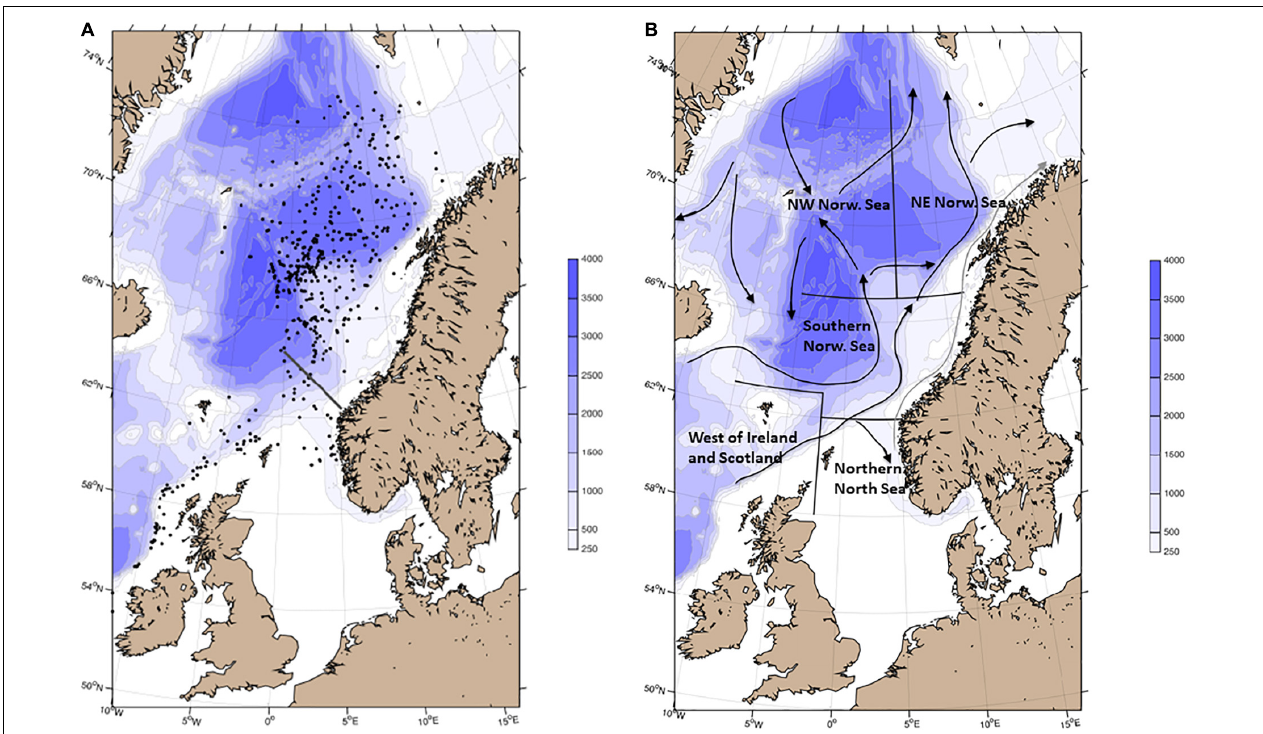
FIGURE 1 | (A) The geographic distribution of sampled post-smolts. Each circle represents a location where post-smolts were sampled, but the number of individuals within each location vary from one to tens of post-smolts. Black solid line off the Norwegian coast around 63 ◦ N represents the survey transect measuring hydrography and sampling zooplankton (Svinøy section). (B) Map of the study area with the different sub-regions addressed in the analyses, and arrows representing the general currents in the Northeast